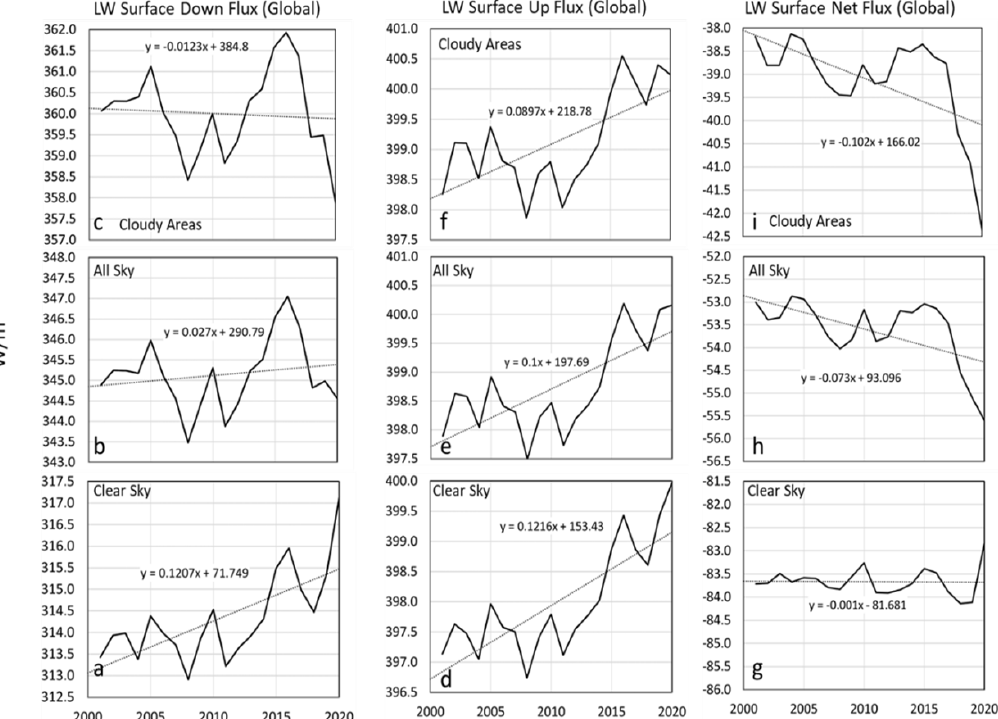
Figure 11. Global average LW downwelling ( a – c ), upwelling ( d – f ), and net ( g – i ) surface fluxes for “Clear Sky”, “All Sky”, and “Cloudy Areas”.